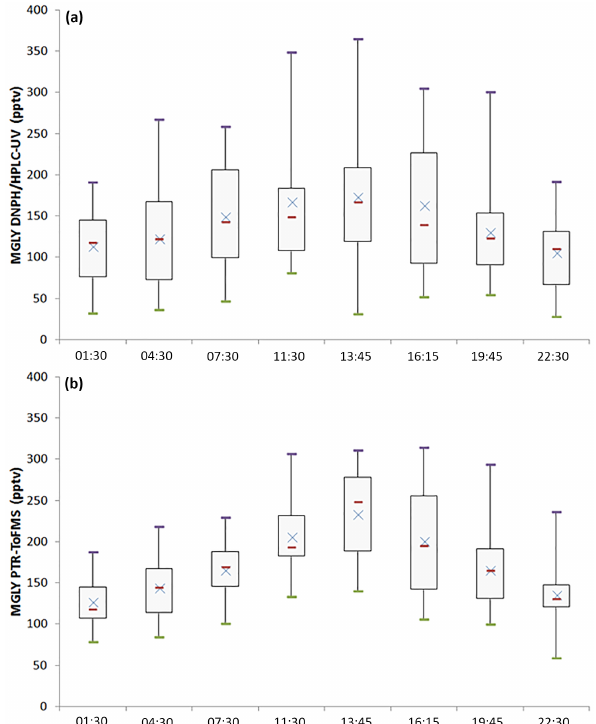
Figure 3. Diurnal profiles (box plots) of MGLY measured by both PTR-ToF-MS (b) and active sampling on DNPH cartridges (a) for the campaign average. Purple bars represent the maxima, green bars the minima, red bars the medians, blue crosses the averages, and the sides of the boxes are the first (b) and the third (a) quartiles.